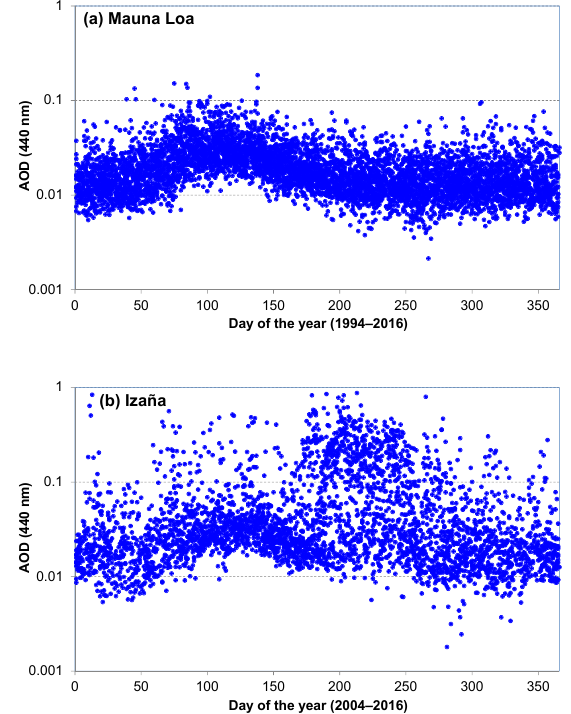
Figure 2. Daily means of aerosol optical depth (440nm) as a function of the day of the year at (a) Mauna Loa (1994–2016) and (b) Izaña (2004–2016) using AERONET